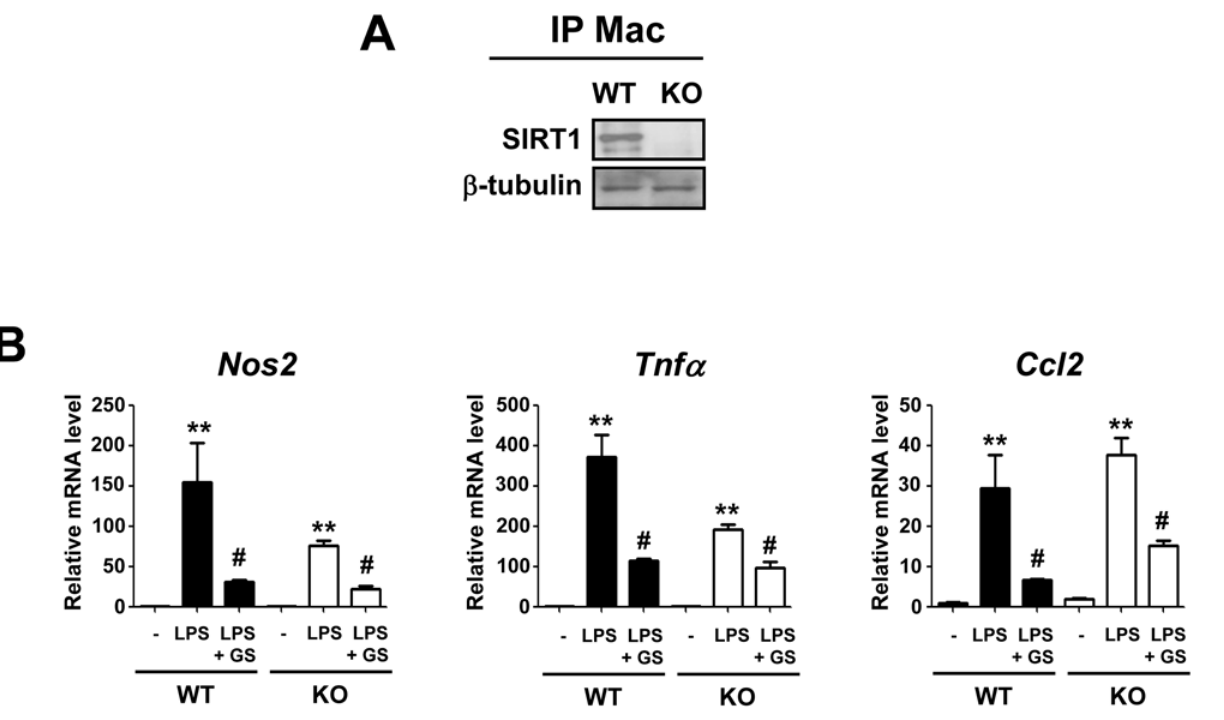
Fig 8. Anti-inflammatory effect of GS12021 was preserved in SIRT1 knockout (KO) macrophages. (A) SIRT1 expression in peritoneal macrophages obtained from wild-type (WT) or myeloid-specific SIRT1 KO mice. Peritoneal macrophages were isolated from WT or SIRT1 KO mice as described in the Materials and Methods section. (B) mRNA levels of inflammatory genes measured by RT-qPCR in macrophages from WT or SIRT1 KO mice. Cells were pretreated with GS12021 for 1 h, and then treated with LPS (10 ng/mL) for 6 h. ** P < 0.01 versus CON, # P < 0.05 ## P < 0.01 versus LPS alone.